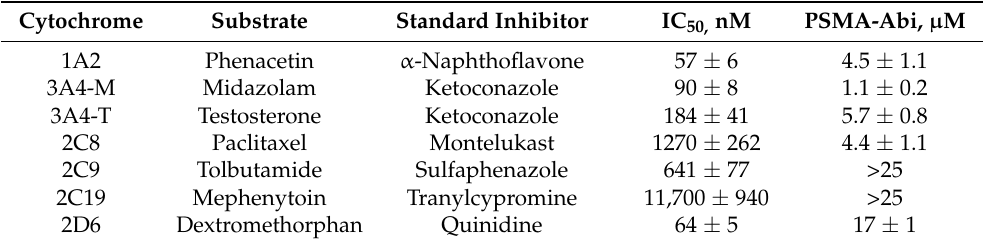
Table 3. Inhibition of series of P450 cytochromes (1A2, 3A4-M, 3A4-T, 2C8, 2C9, 2C19, and 2D6)